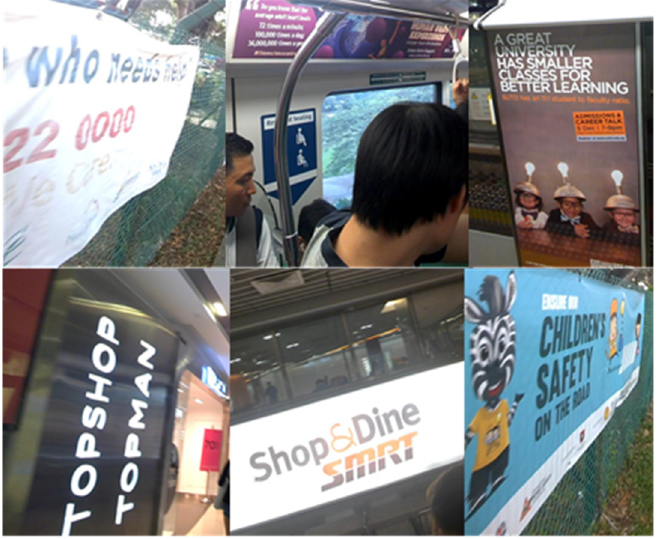
Figure 6. The background of the ICDAR 2015 data set is complex and changeable, the scale and direction of the text are arbitrary, and there is a phenomenon of tightly arranged